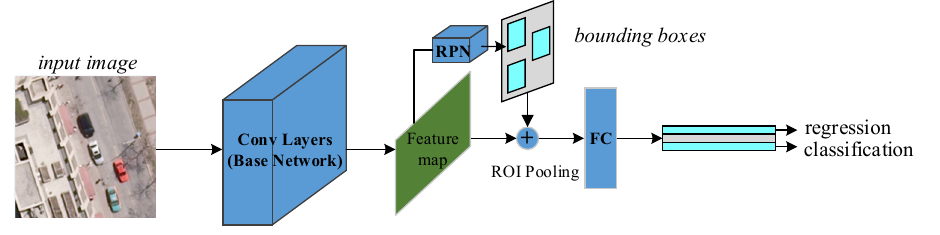
Figure 1. Flowchart of the faster R-CNN.